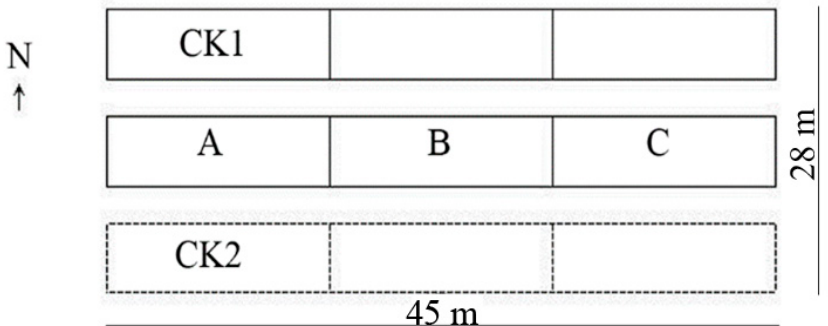
Figure 1. Plan graph of the net pollination houses built in the oil tree peony (‘Feng Dan’) plantation. A, B, and C are the A. mellifera net rooms. CK1 includes three net rooms without bees. CK2 is the field area with natural pollination.